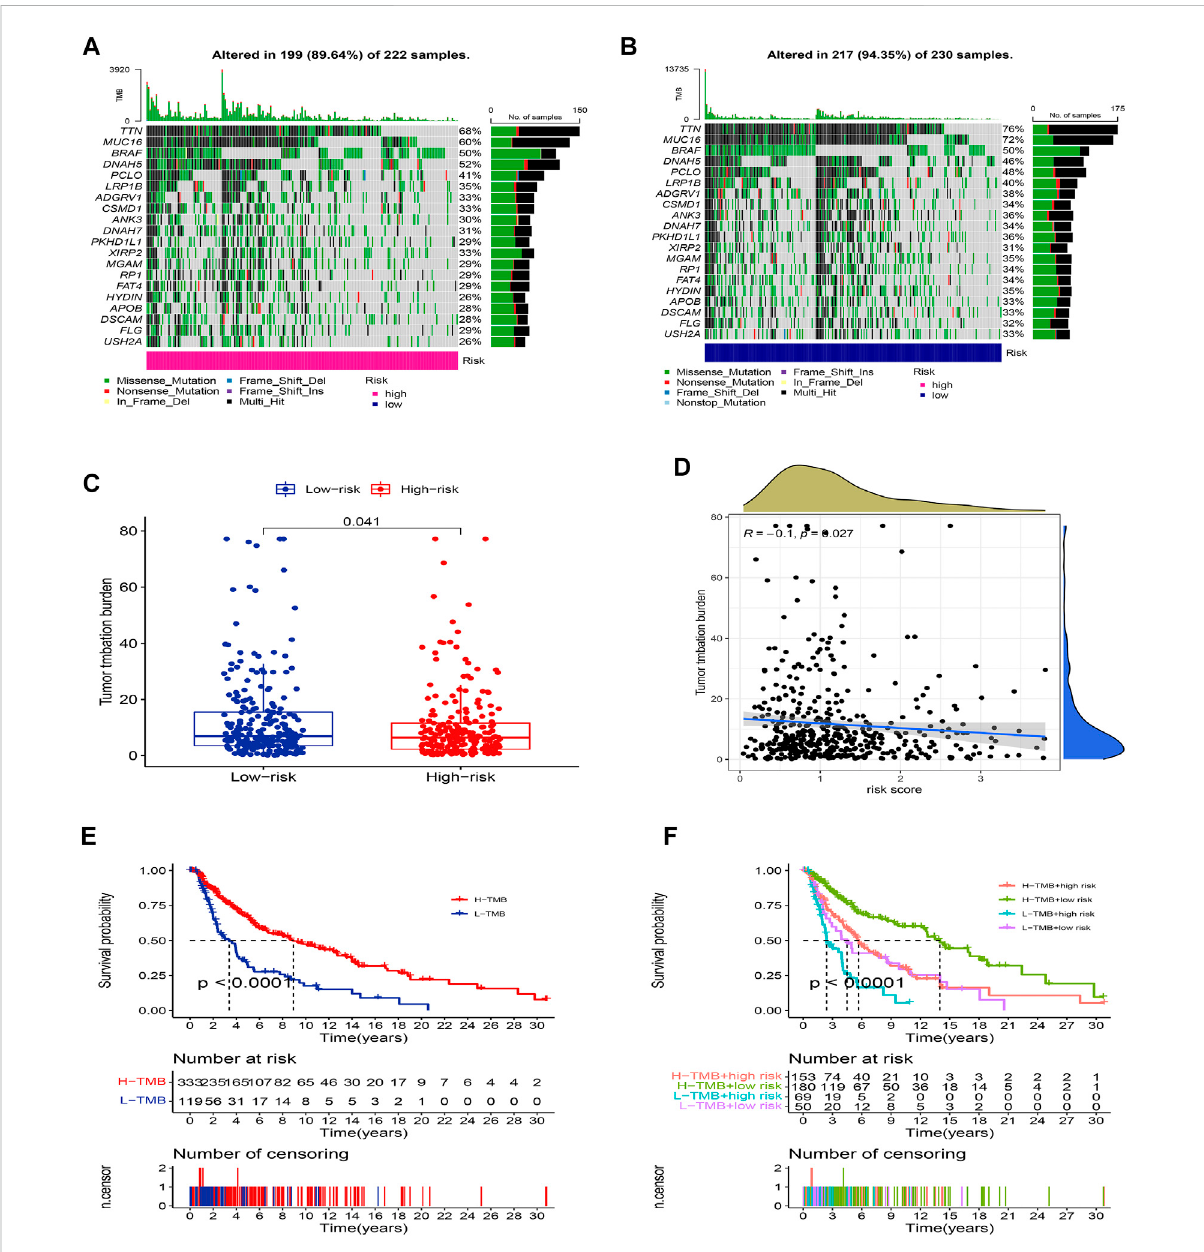
FIGURE 9 Landscape of mutation between two groups. The mutation distributions of patients in the high-risk group (A) , and low-risk group (B) . (C) The difference in TMB score between the two groups. (D) Correlations between risk score and TMB. (E) K-M analysis of the OS between high- and low- TMB groups. (F) K-M analysis of the OS between four groups strati fi ed by both TMB and risk